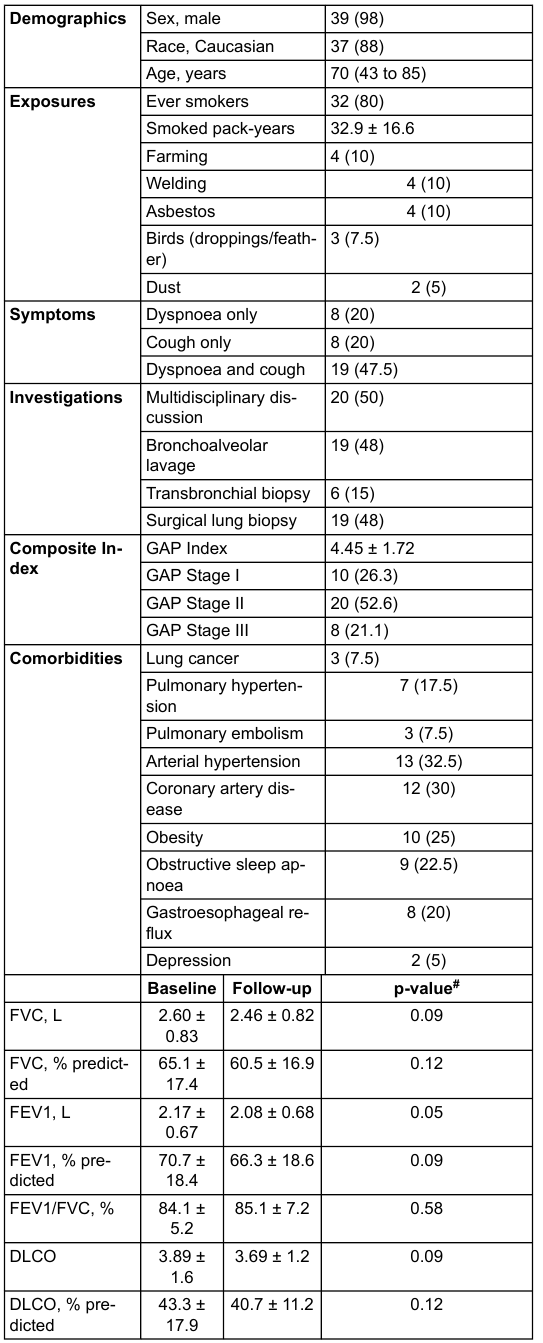
Table 1: Patient characteristics at baseline including pulmonary func- tion tests at follow-up. Sex, male 39